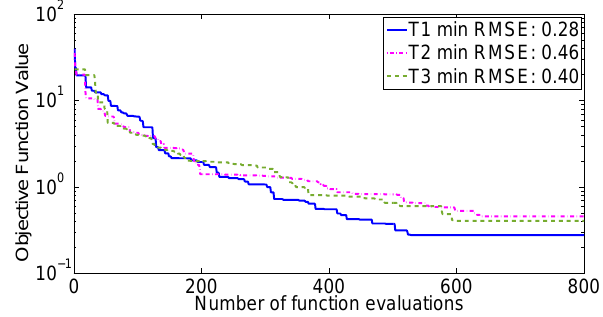
Figure 1. Progress plot that shows the development of the best ob- jective function value found vs. the number of function evaluations for the pseudo data case with d = 5 parameters for optimization tri- als T1, T2, and T3. The legend shows the lowest RMSE value found in each